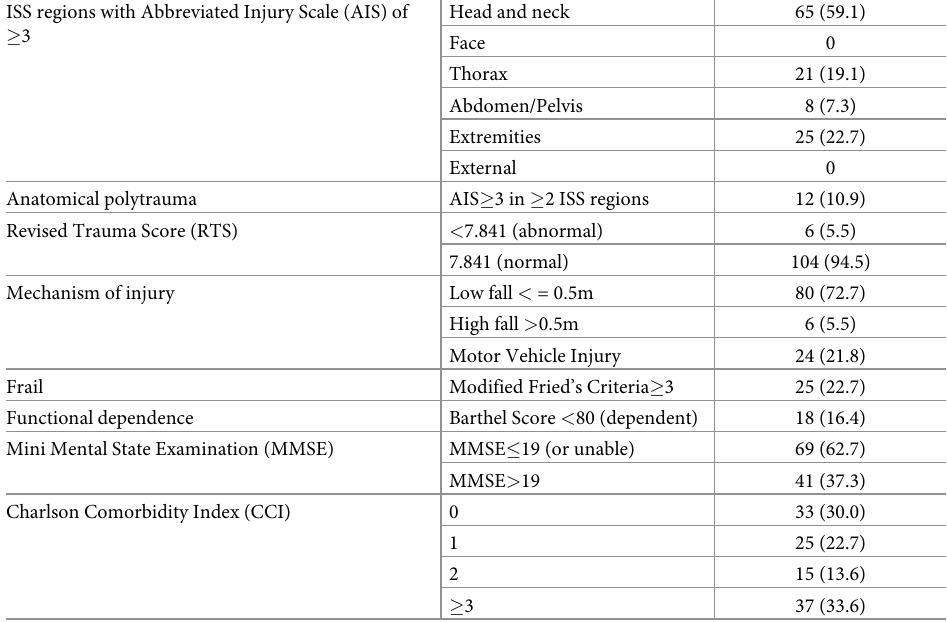
Low fall patients (defined as � 0.5m) constituted the majority of patients (93, 72.7%), fol- lowed by patients of motor vehicle accidents (28, 21.9%), and higher-level fallers (7, 5.5%). Twelve patients (21.9%) were determined to be frail as per modified Fried’s criteria.